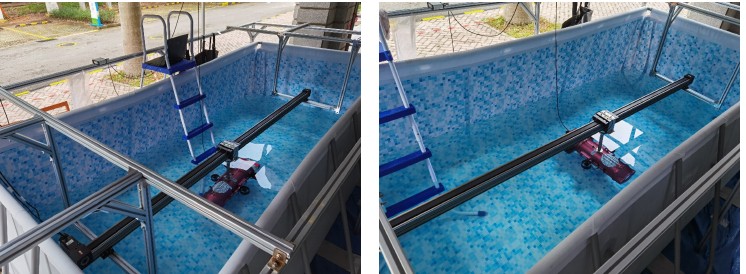
Figure 29. Hydrodynamic coefficient estimation of the Shark-AUV based on the established physical experiment platform. The left diagram shows cruising forward along the x -direction, and the right one shows cruising forward along the y